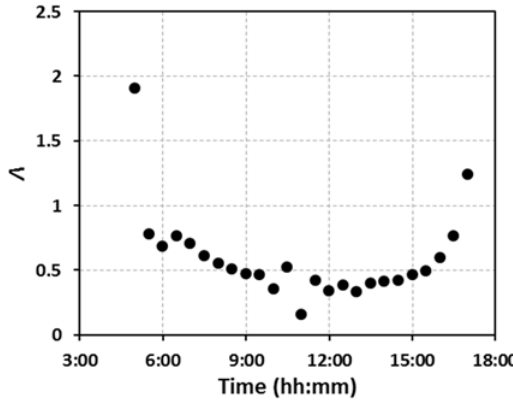
Figure 7. Diurnal Λ behavior during the image acquisition day.